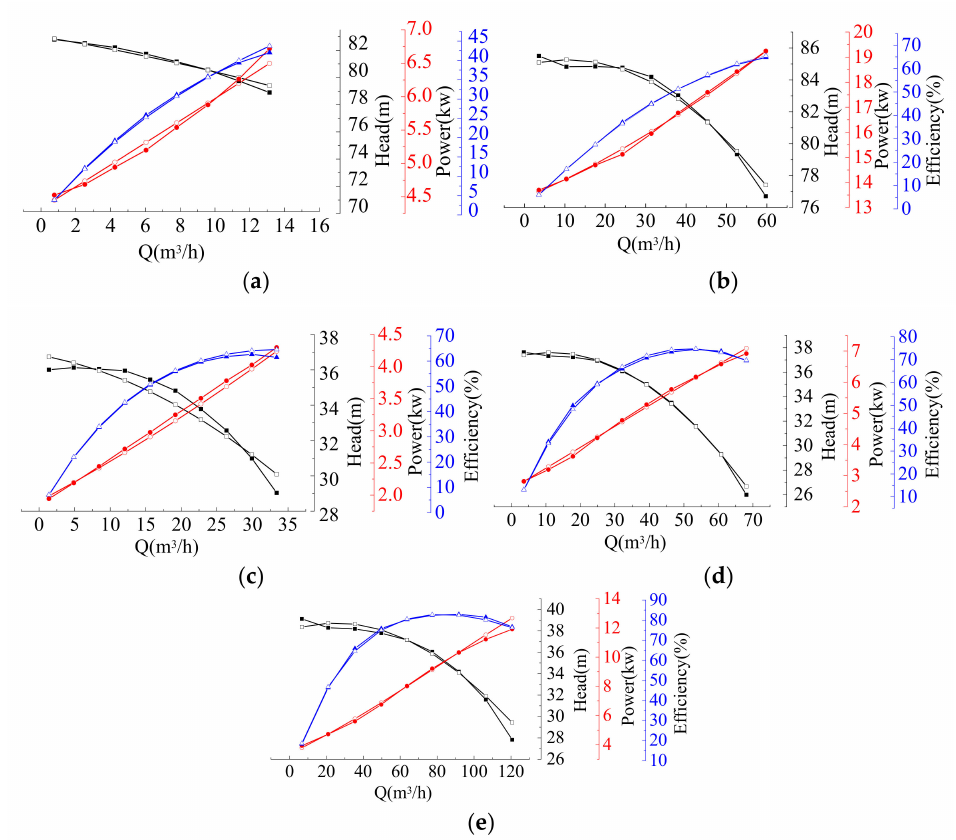
Figure 8. Comparison of performance prediction results of five single-stage single-suction centrifugal pumps. ( a – e ) are the prediction results of centrifugal pumps with n s = 23.4, 46.2, 63.2, 90.7 and 125.3,